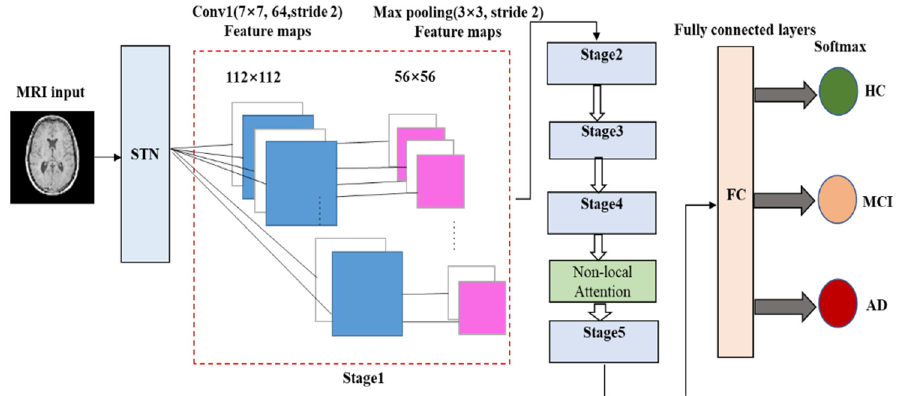
Figure 5. The framework of the proposed method.